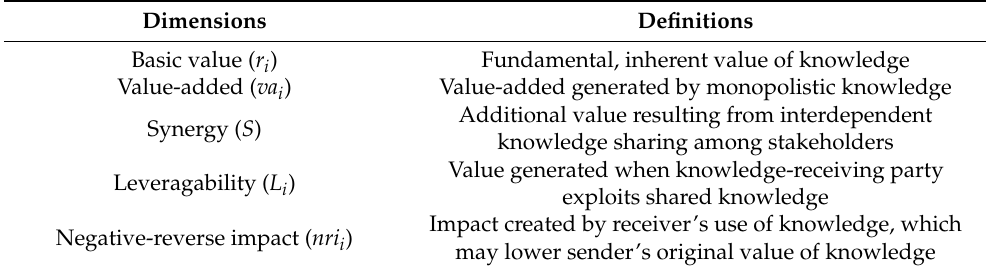
Table 1. Five dimensions for quantifying value of knowledge in co-opetition (Loebecke et al., 1999).